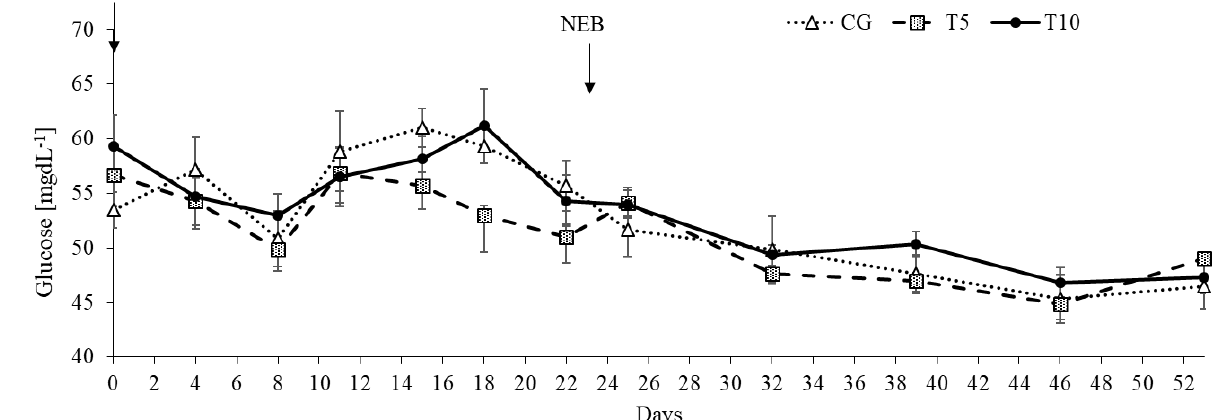
Figure 4. Blood glucose response under positive (PEB) and negative energy balance states (NEB) in the control and thiamine treated groups. Effect of Treatment ( p = 0.54), Nutritional State ( p < 0.0001), time ( p < 0.0001), and Treatment by